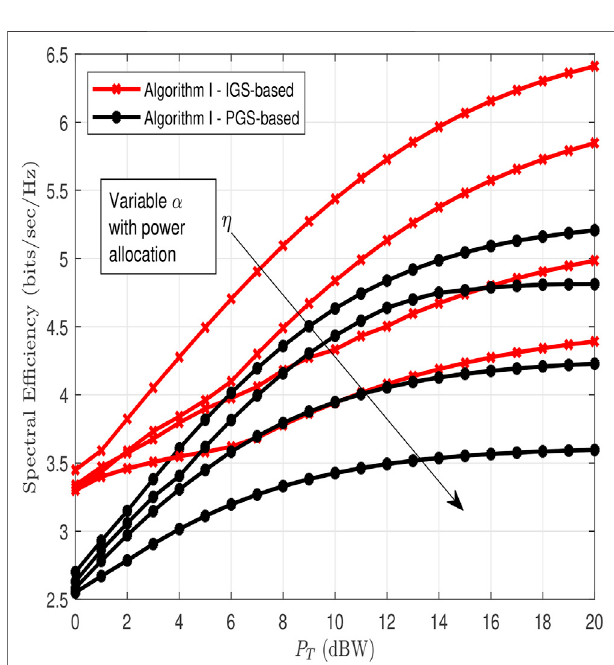
FIGURE 5 | Spectral ef fi ciency comparison between IGS-based and PGS-based for various values of η = 0.1, 0.2, 0.3, 0.4 and optimized α .